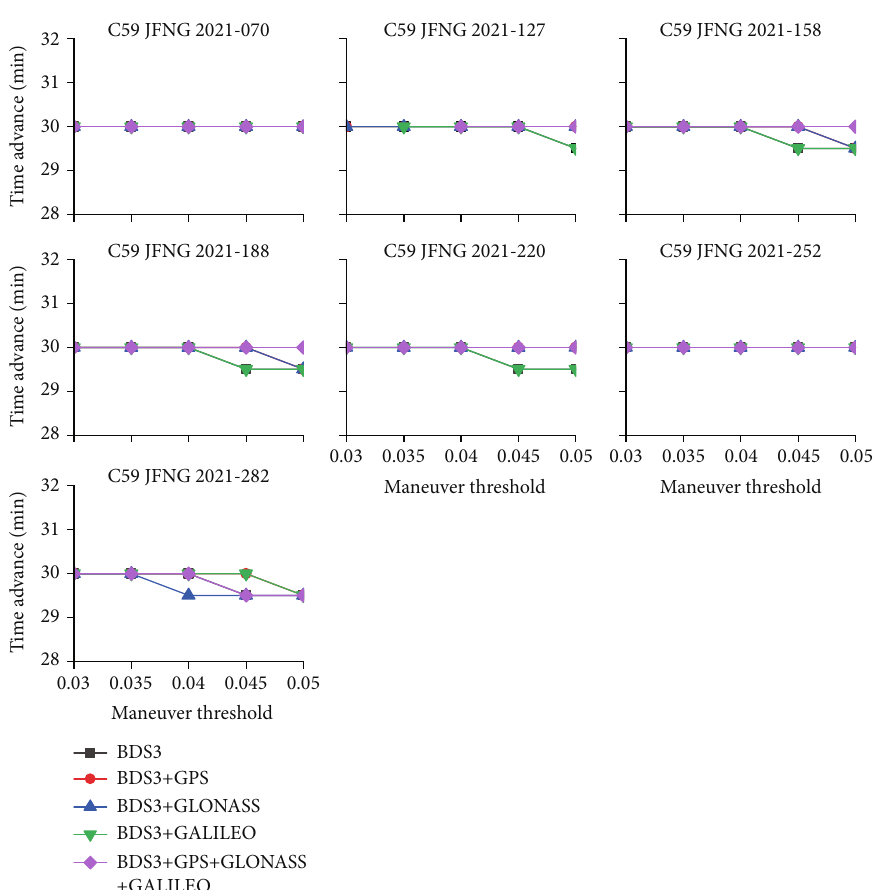
Figure 6: Comparison of detection results of C59 under di ff erent maneuvering